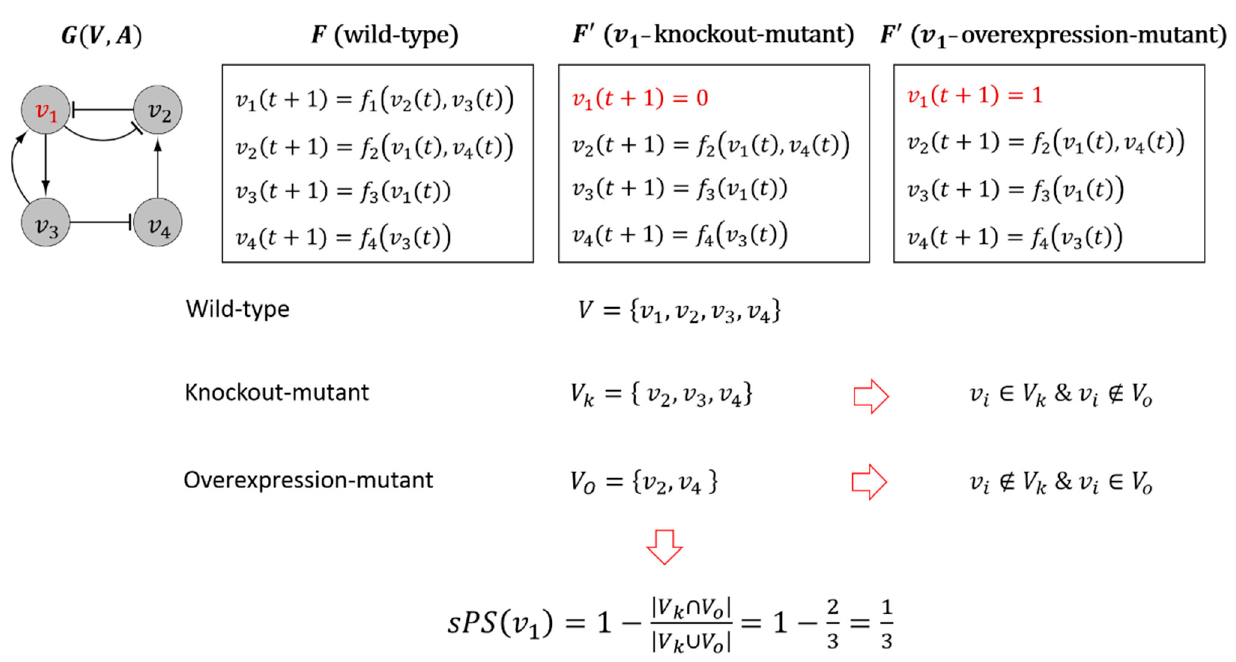
Figure 1. An illustrative example of sPS computation. An example of a signaling network G ( V , A ) with a set of update rules F . Let v 1 a node subject to the knockout or the overexpression mutations. The mutations change F to F (cid:48) where the state value of v 1 is frozen to 0 and 1, respectively, for t ≤ T . The sets of genes whose dynamics are influenced by the mutations are identified as V k and V o , respectively. Accordingly, sPS of v 1 is computed as the ratio of the symmetric difference of V k and V o over the union of them.